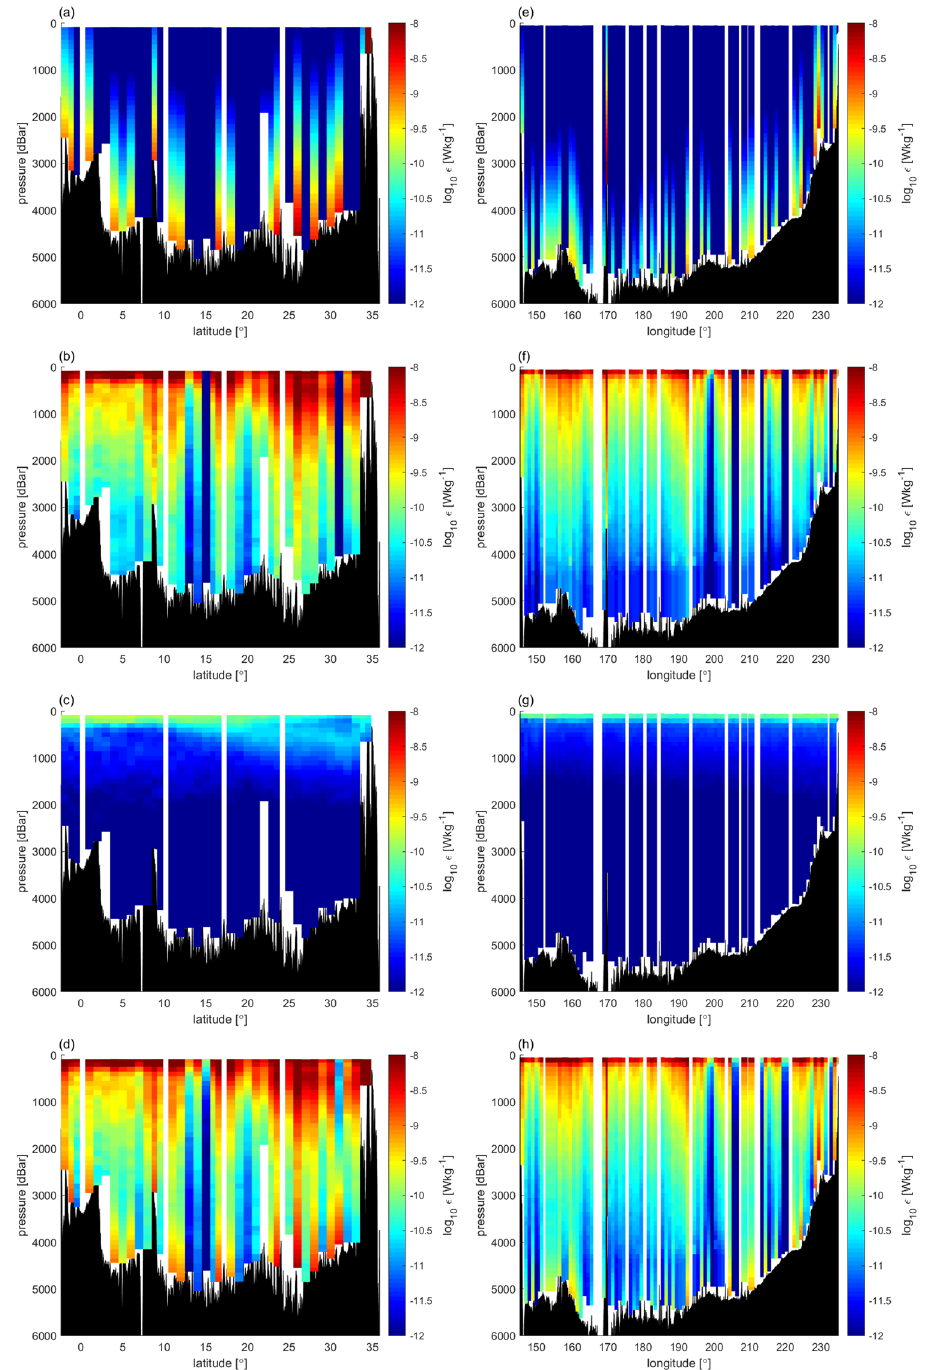
Figure 7. Modified ε MOD distribution adjusted to the observed ε . ( a , e ) Near-field ε NEAR , ( b , f ) Far-field ε FAR , ( c , g ) Background ε BACK , ( d , h ) ε MOD = ε NEAR + ε FAR + ε BACK